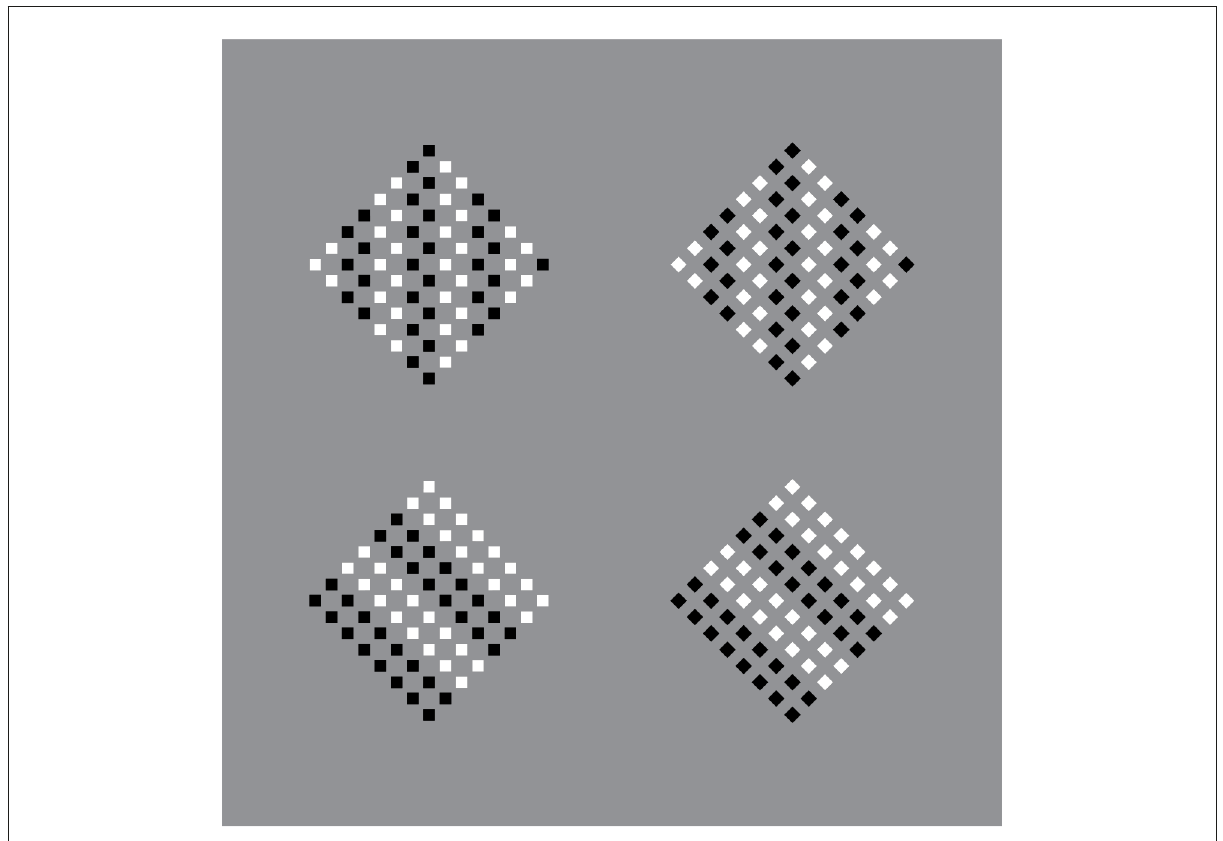
FIGURE8 Squares and diamonds perceived as squares and diamonds (first row); squares perceived as diamonds and diamonds perceived as rotated squares (second row).